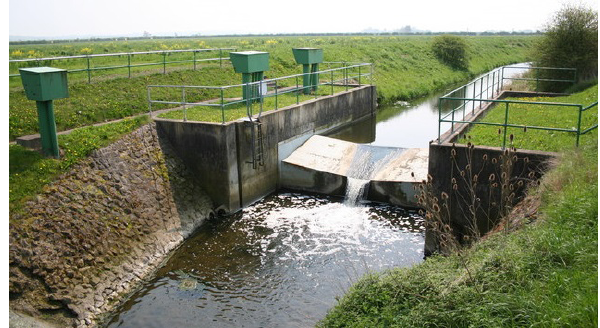
Figure 3. Brant Broughton gauging station, UK.